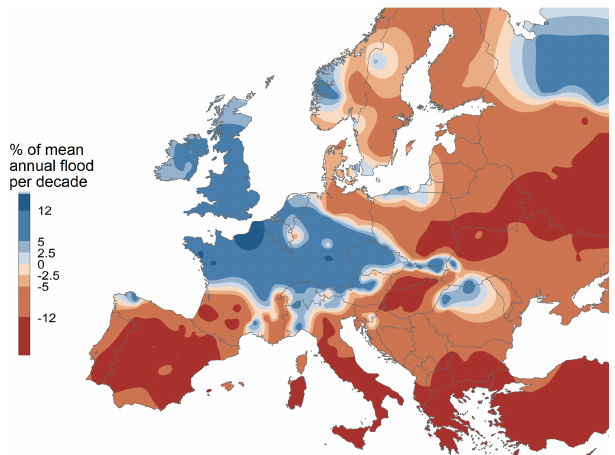
Figure 13. Observed flood trends in the period 1960–2010 based on the analysis of runoff data. Blue colours indicate an increasing trend and reddish colours a decreasing trend in the median flood peak runoff. Only stations with significant trends (significance level α = 0 . 1) were used in the spatial interpolation (664 stations) (Blöschl et al.,